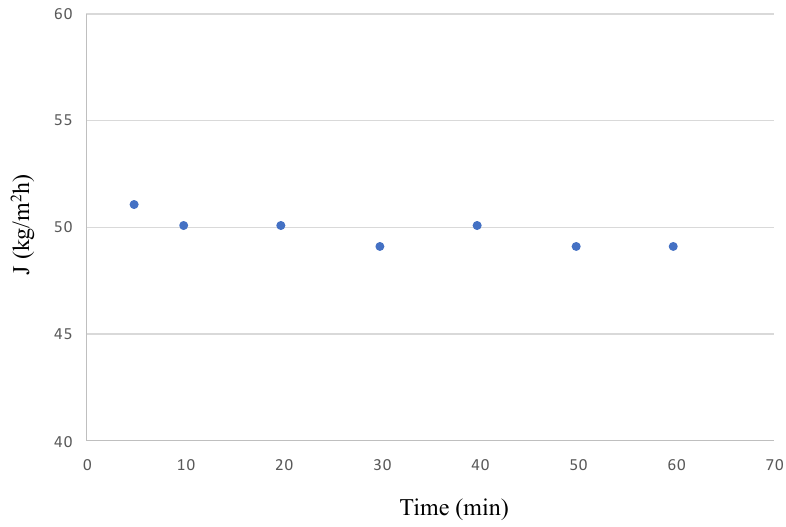
Figure 10. DCMD tests. Effect of feed temperature and concentration on ( a ) the flux and ( b ) the permeate conductivity.